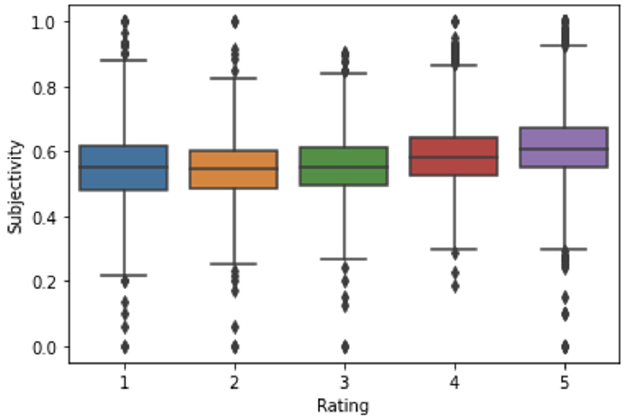
Figure 5. Correlation between “Subjectivity” and